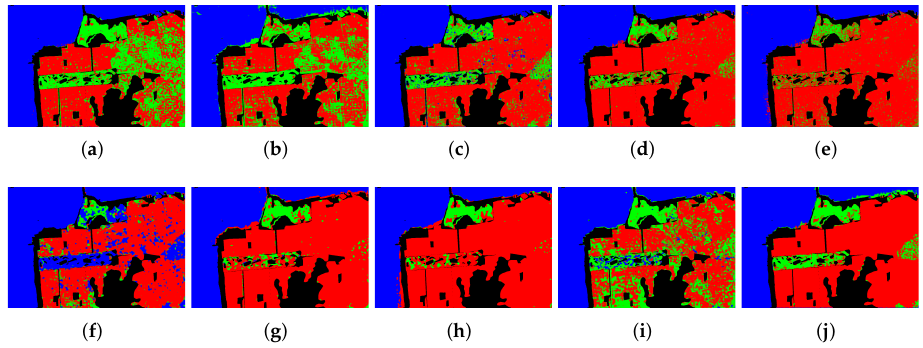
Figure 9. Classification results of San Francisco with different methods. ( a ) SVM. ( b ) Wishart.